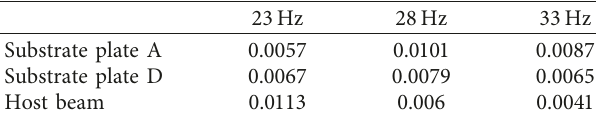
Figure 8: Voltage in time history and the phase portrait for the linear EMM system: (a) voltage-time@23Hz; (b) phase portrait@23 Hz; (c) voltage-time@28 Hz; (d) phase portrait@28 Hz; (e) voltage-time@33Hz; (f) phase portrait@33Hz. Table 3: Averaged displacement (m) of the linear EMM system in 100seconds.